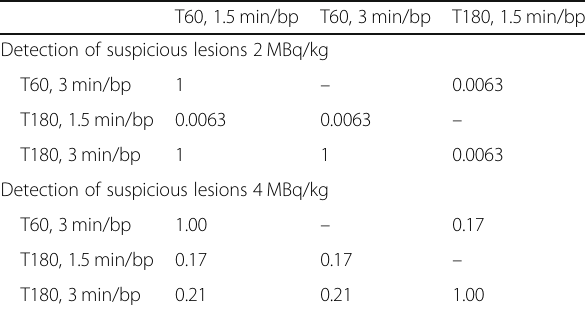
Table 5 p values of the pairwise comparison of the lesion detectability within the 2 MBq/kg group and the 4 MBq/kg group for all sets of reconstructed images. p values < 0.05 were considered statistically